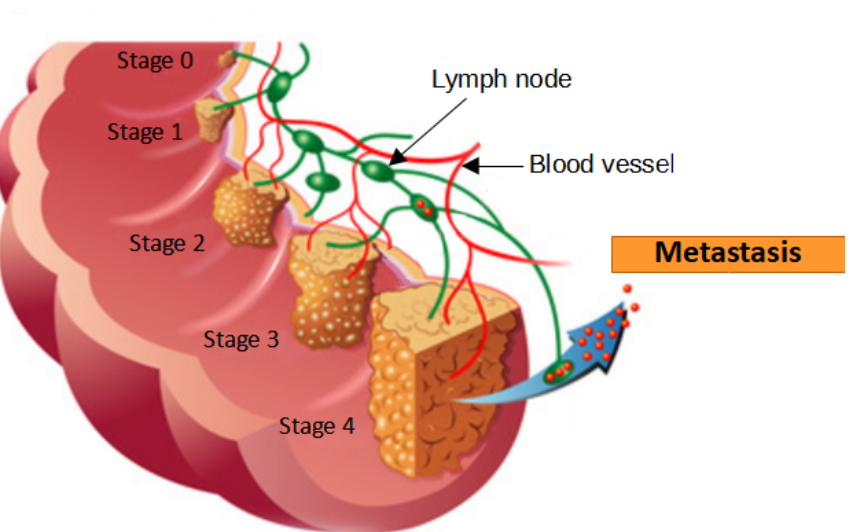
Figure 1. ( A ) Polyps as precancerous intestinal cancer, ( B ) colonic carcinogenesis stages. Adapted from the PhD Thesis of Dr F. Mazué (Director of Thesis; Prof. N. Latruffe; https://www.theses.fr/165862416, accessed on 7 June 2021).